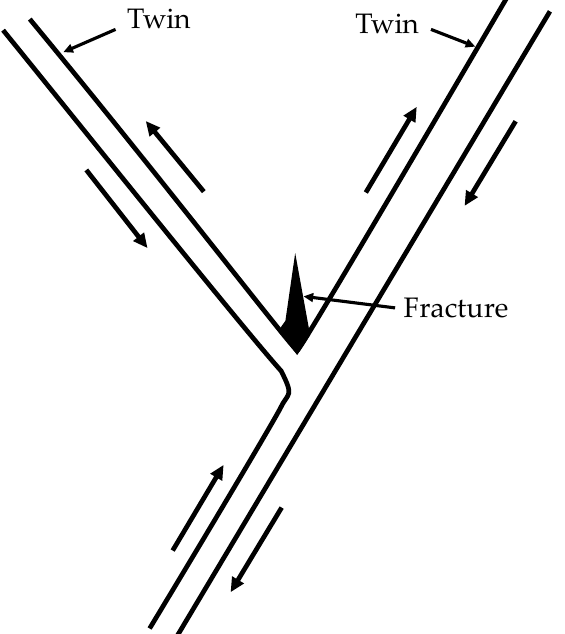
Figure 1. A schematic illustrating crack nucleation at the intersection of two twins, adapted from Priestner [16].